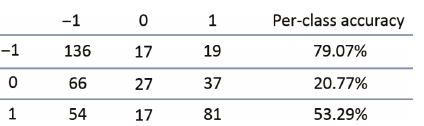
Figure 22: Training Confusion Matrix of Experiment 1.